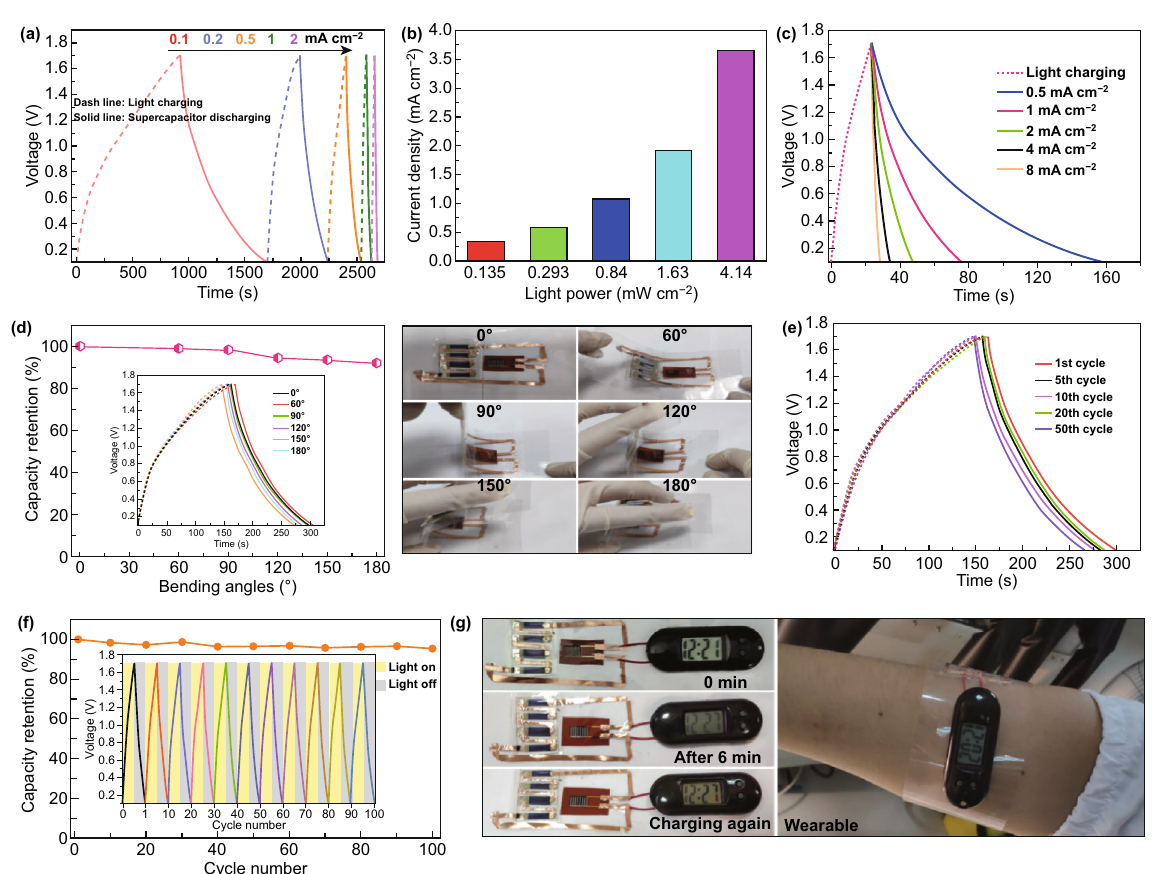
Fig. 6 a Solar-charging/discharging curves of the integrated self-powered unit at different light intensities/discharge current densities. b Output current densities of the OSCs at different light intensities. c Solar-charging/discharging curves at the same light intensity and different discharge current densities. d Capacity retentions of the unit at different bending angles from 0° to 180° and corresponding GCD curves. e Cycling stabil- ity of the unit at a bending angle of 120° for 50 cycles. f Cycling performance of the unit at 1 mA cm −2 . g Proof-of-concept demonstration of the flexible solar-charging self-powered unit powering an electronic